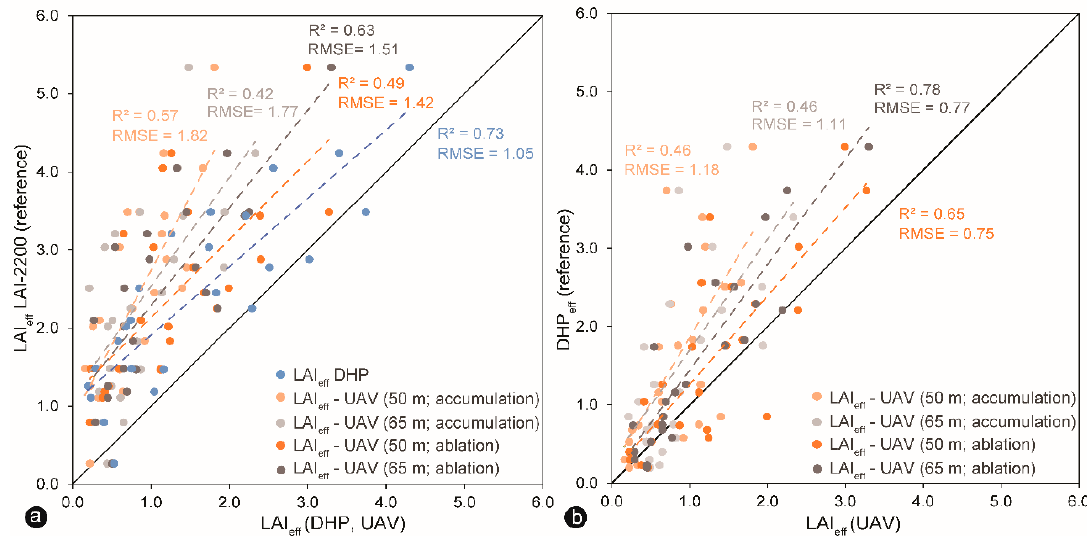
Figure 9. Comparison of effective LAI values produced by LAI-2200 as a reference (plot a ; y-axis); hemispherical digital photographs (DHP) as a reference (plot b ; y-axis), and UAV (x-axis in both plots) processed in FV2000 and Gap Light Analyzer (GLA) software. Graphs show the regression functions (dashed lines) and 1:1 correspondence (solid lines).